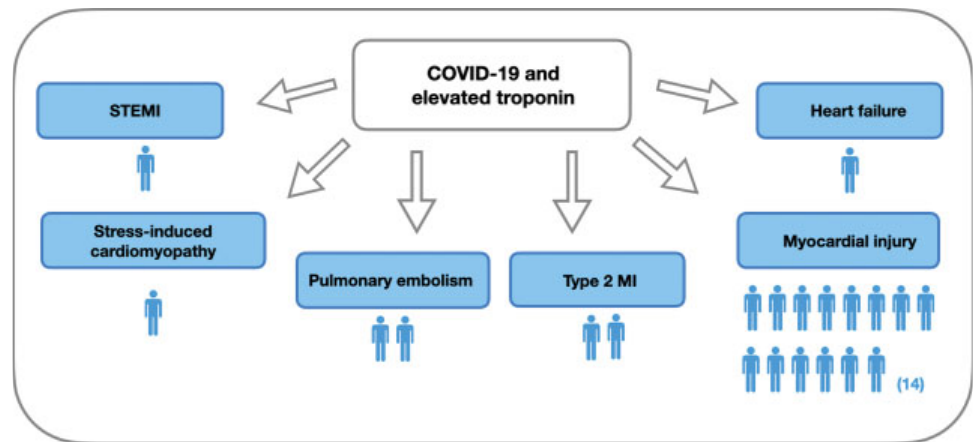
Fig. 1 Cardiovascular manifestations of COVID-19 infection during the pandemic peak. CHF, cardiac heart failure; COVID-19, novel coronavirus disease 2019; MI, myocardial infarction; NSTEMI, non-ST-elevation MI; STEMI, ST-elevation MI.